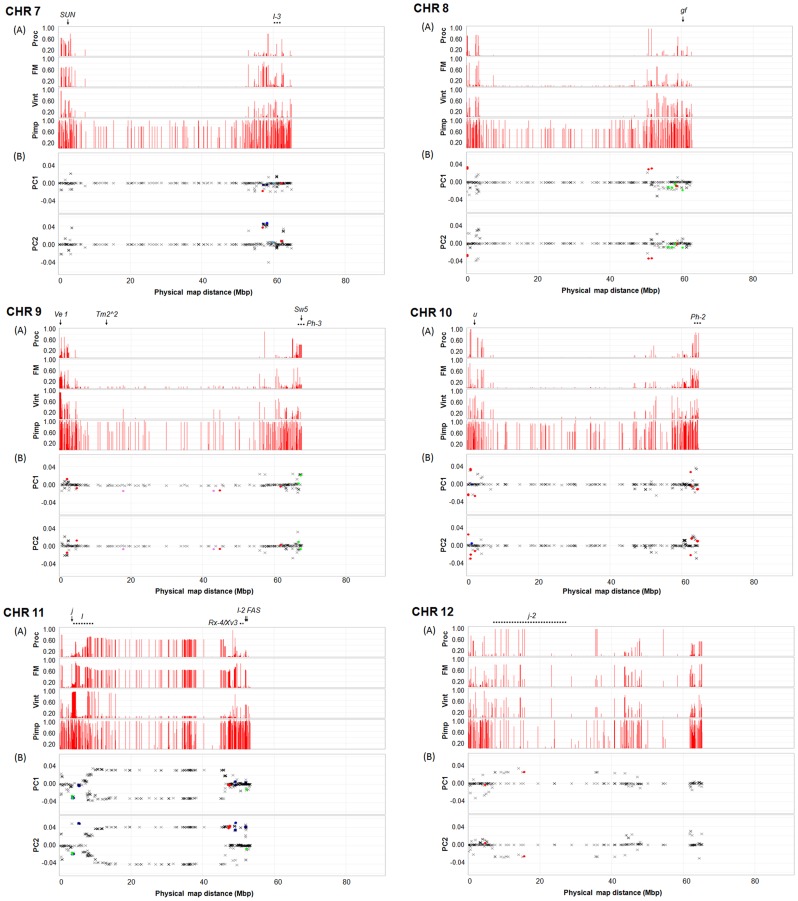
Minor allele frequency (MAF) patterns, PCA loadings, and F
st outliers on chromosomes 7 to 12.The minor allele was determined relative to allele calls for all 410 inbred accessions based on 7,310 SNPs, and then MAF was estimated and graphed for processing (Proc), fresh market (FM), and vintage (Vint) and S. pimpinellifolium (Pimp) sub-populations (A). The 28 tomato genes listed in Table S9 are positioned based on their coding sequences (arrow) and flanking markers (dotted line). The Y-axis represents allele frequency and the X-axis represents physical positions of the SNPs oriented with respect to the tomato genome sequence [102]. PCA loadings for PC 1 and PC 2 are graphed with candidates for loci under positive selection based on F
st outlier analysis [27], [28] (B). The candidate loci are indicated by dots (•) with a color scheme indicating pairwise comparisons that were significant: red for Proc vs. FM; green for Vint vs. Proc; blue for Vint vs. FM; violet for Proc vs. FM and Vint; sky blue for FM vs. Proc and Vint; and gold for Vint vs. Proc and FM. All other loci are indicated by X (black).